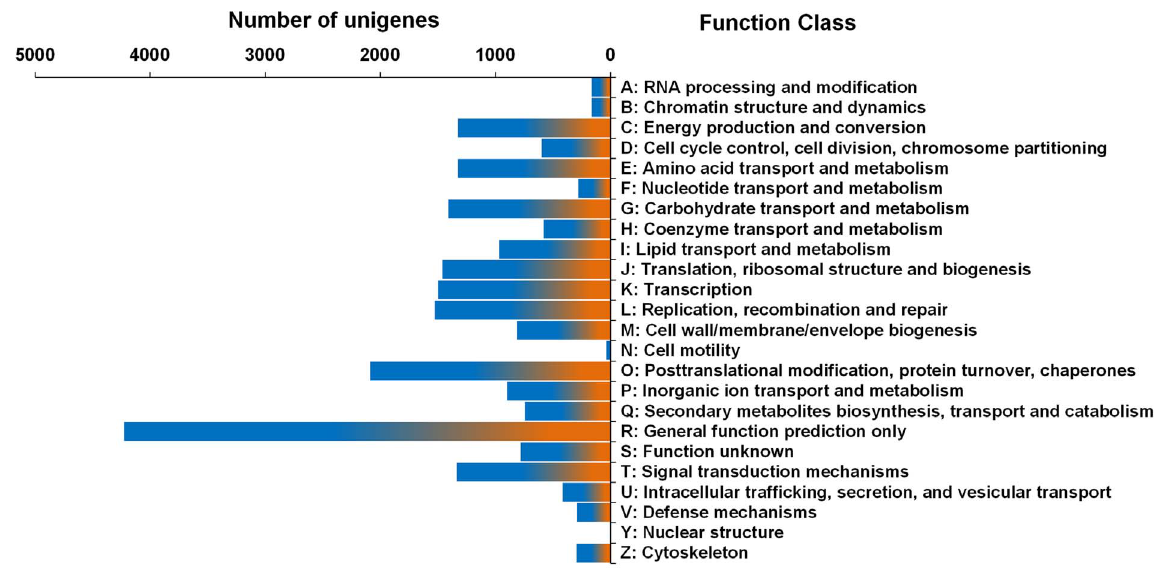
Figure 2. Clusters of orthologous groups (COG) classifications of yellow horn unigenes.